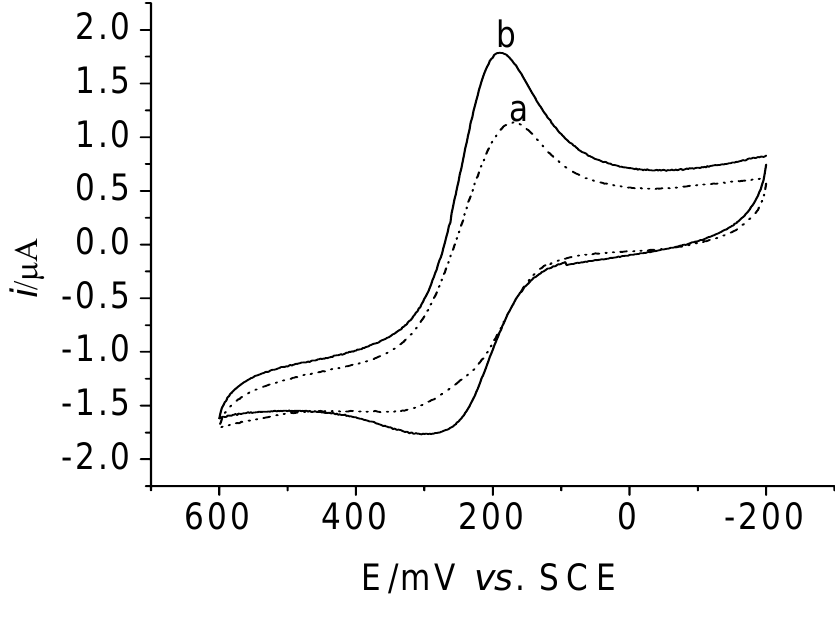
Figure 5. Cyclic voltammograms of CS/Fc electrode (a) and CS/HRP/Fc (b) obtained in 10.0 mL 0.02 M pH 7.0 PBS. Scan rate 100 mV s -1 .